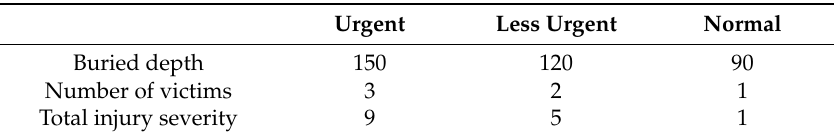
Table 3. Evaluation criterion of tasks’ urgency